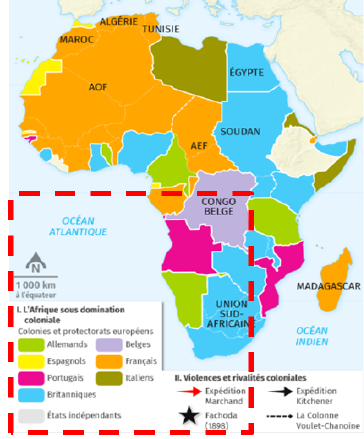
Figure 9: This map of Africa contains a large legend, but when cut in four for data augmentation, the bottom left part (red dashes) is mainly the legend and the sea, and we do not see the map so much.